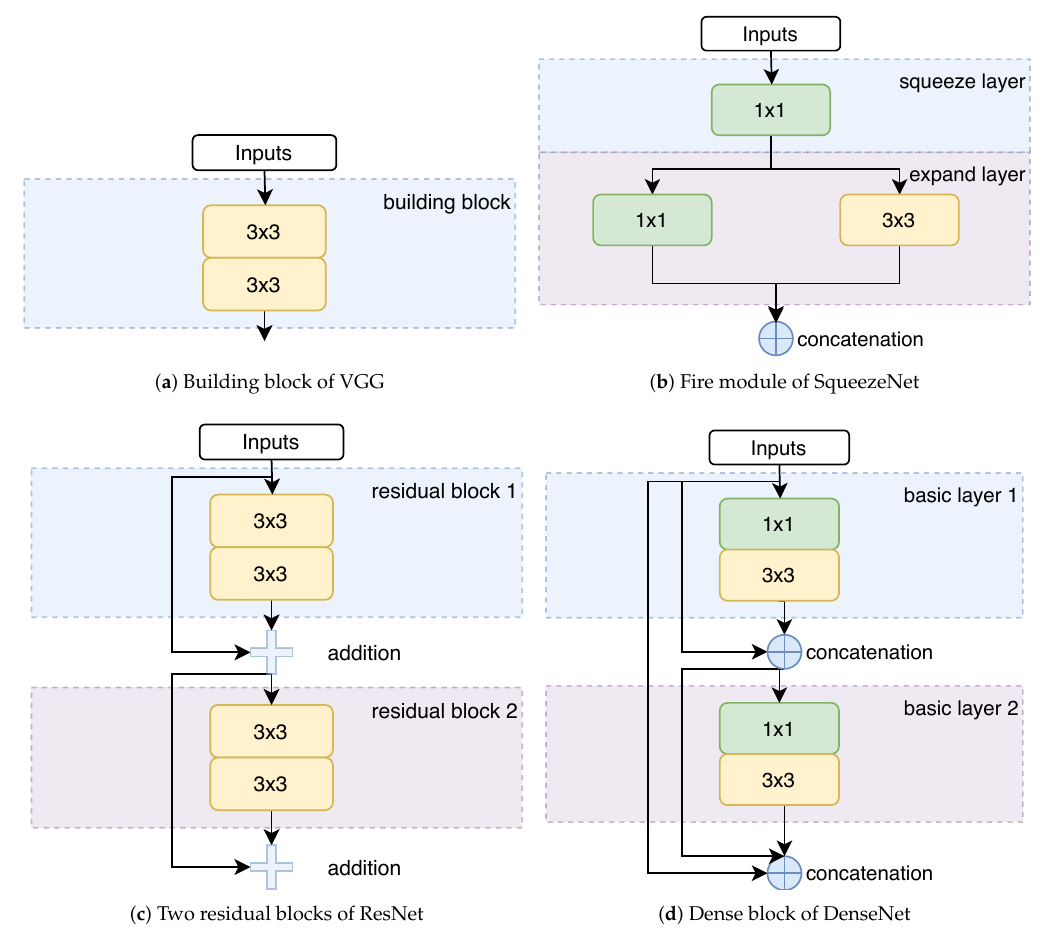
Figure 5. Comparison of basic building blocks of ( a ) the VGG architecture, ( b ) the SqueezeNet architecture, ( c ) the ResNet architecture, ( d ) the DenseNet architecture. For better comparison two residual blocks are illustrated. A n × n block indicates a convolutional layer with the kernel size of n × n